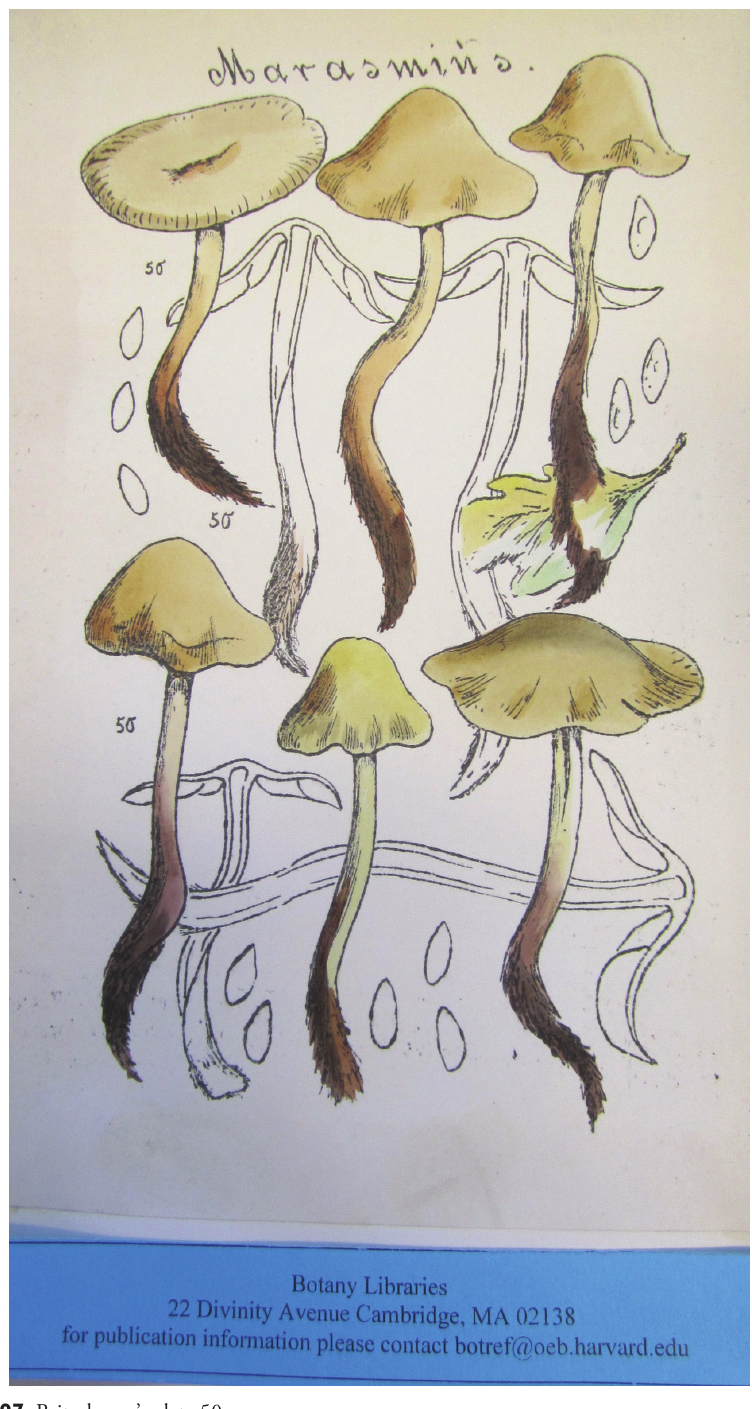
Figure 97. Britzelmayr’s plate